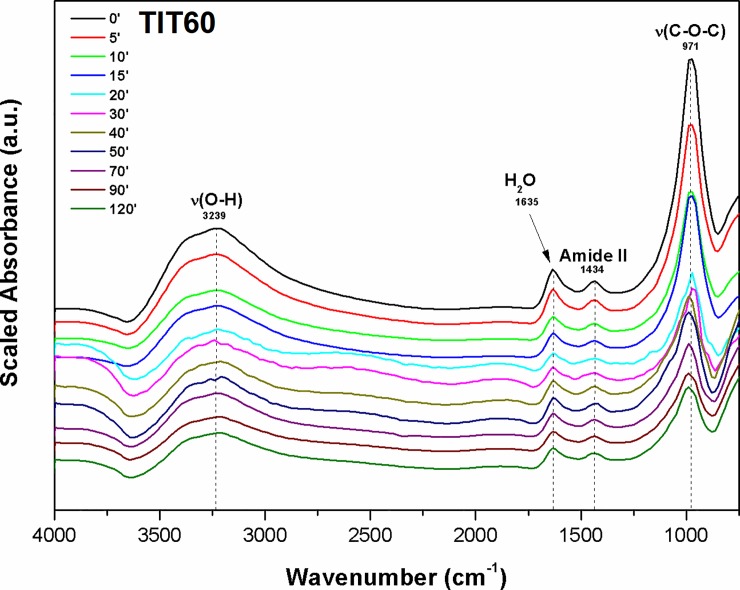
DRIFTS spectra of valrubicin interaction with the TiO2 surface (TIT60).